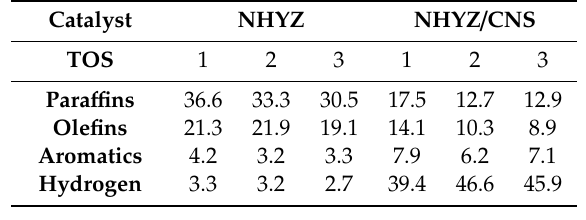
Table 3. Selectivity of NHYZ and NHYZ / CNS catalysts.